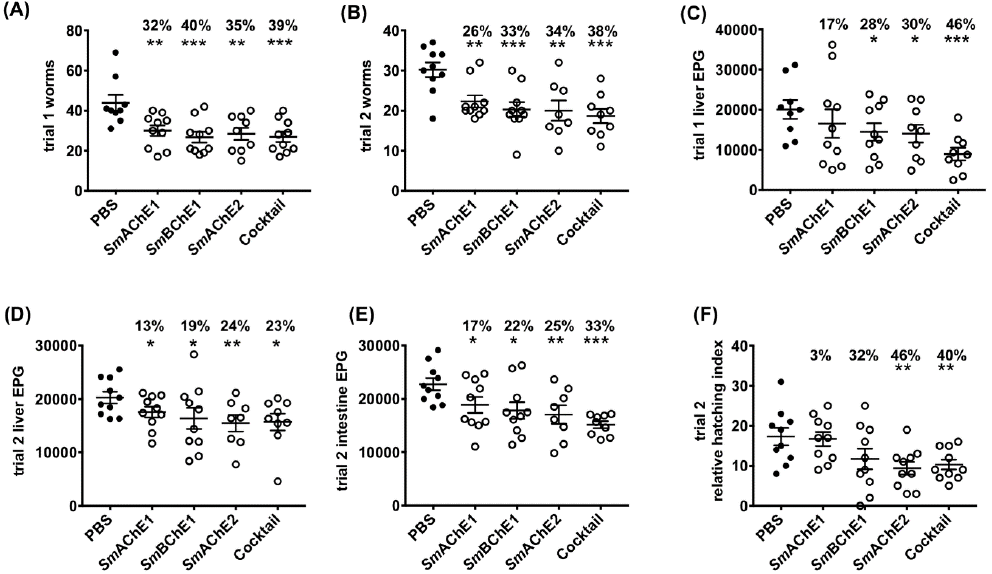
Figure 4. Vaccine efficacy of recombinant Sm ChEs in a mouse model of schistosomiasis. Graphs show parasitology burdens from vaccinated and control mice. ( A ) Trial 1 adult worms. ( B ) Trial 2 adult worms. ( C ) Trial 1 liver eggs per gram (EPG). ( D ) Trial 2 liver EPG. ( E ) Trial 2 intestinal EPG. ( F ) Hatching viability of eggs obtained from the pooled livers of control and vaccinated mice from trial 2. Data are the average of ten replicate counts ± SEM of hatched miracidia. Significance and percent reductions (if any) for all parameters are measured relative to the control group. Significance determined by the student’s t test, where * p ≤ 0.05, ** p ≤ 0.01, *** p ≤